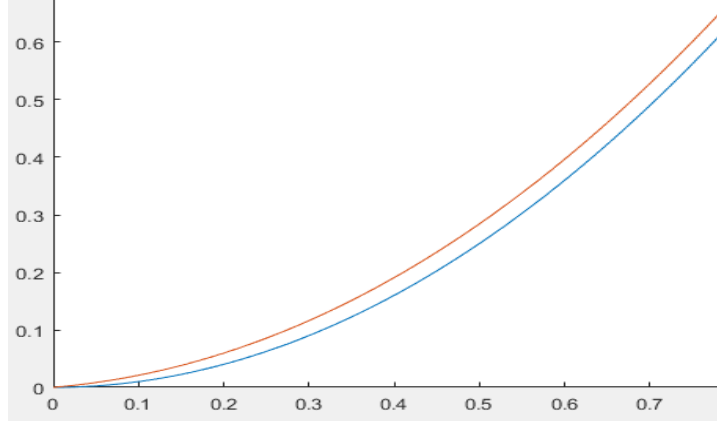
Figure 1. The exact and approximated solutions of the differential equation (20) are shown by the red and blue lines,